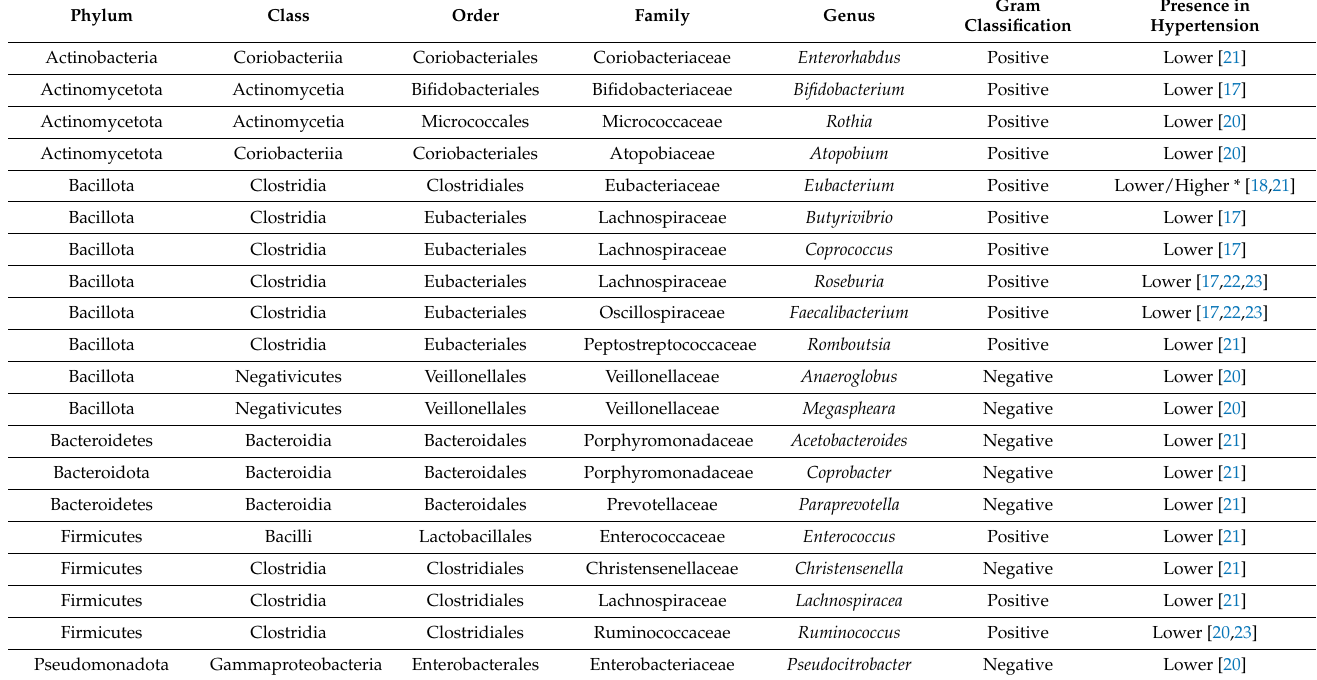
Table 2. Presentation of the bacteria population representing a lower capacity in individuals with hypertension or higher capacity in people with normal blood pressure. The table contains the distribution for phylum, class, order, family, genus and gram